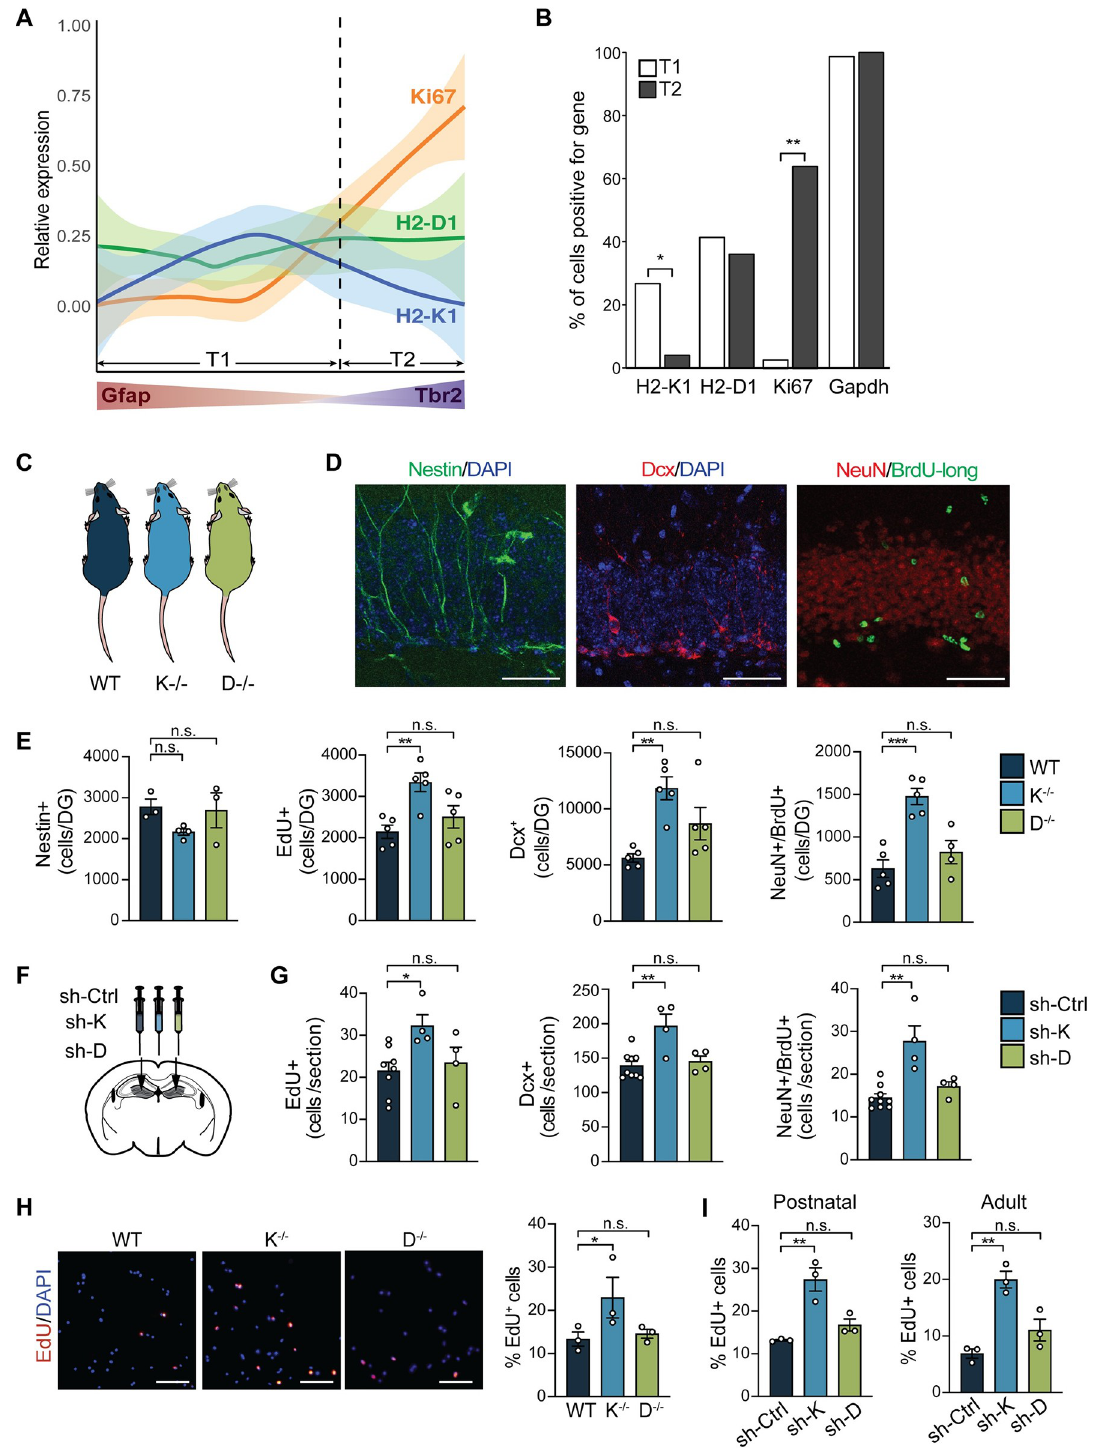
Fig 1. H2-K b , and not H2-D b , negatively regulates adult hippocampal neurogenesis and NSPC proliferation. Relative expression of H2-K1 (H2-K b ), H2-D1 (H2-D b ), and Mki67 (Ki67) along a bioinformatically assigned trajectory of adult neurogenesis. Single adult hippocampal NSCs were ordered according to pseudotime (x-axis) estimates as given in [27]. Relative gene expression (y-axis, log2 (CPM+1)/max(log2(CPM+1))) was fitted with local polynomial regression fitting (bold lines) with 95% confidence interval (light colored area). The cutoff point between time points T1 and T2 was determined by the time of increasing Tbr2 expression (last